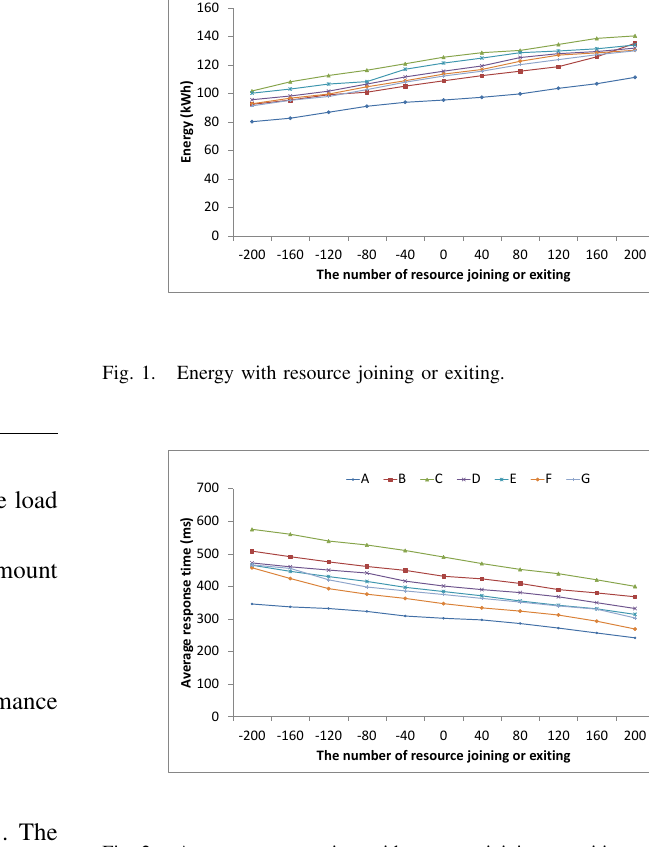
Fig. 2. Average response time with resource joining or exiting.